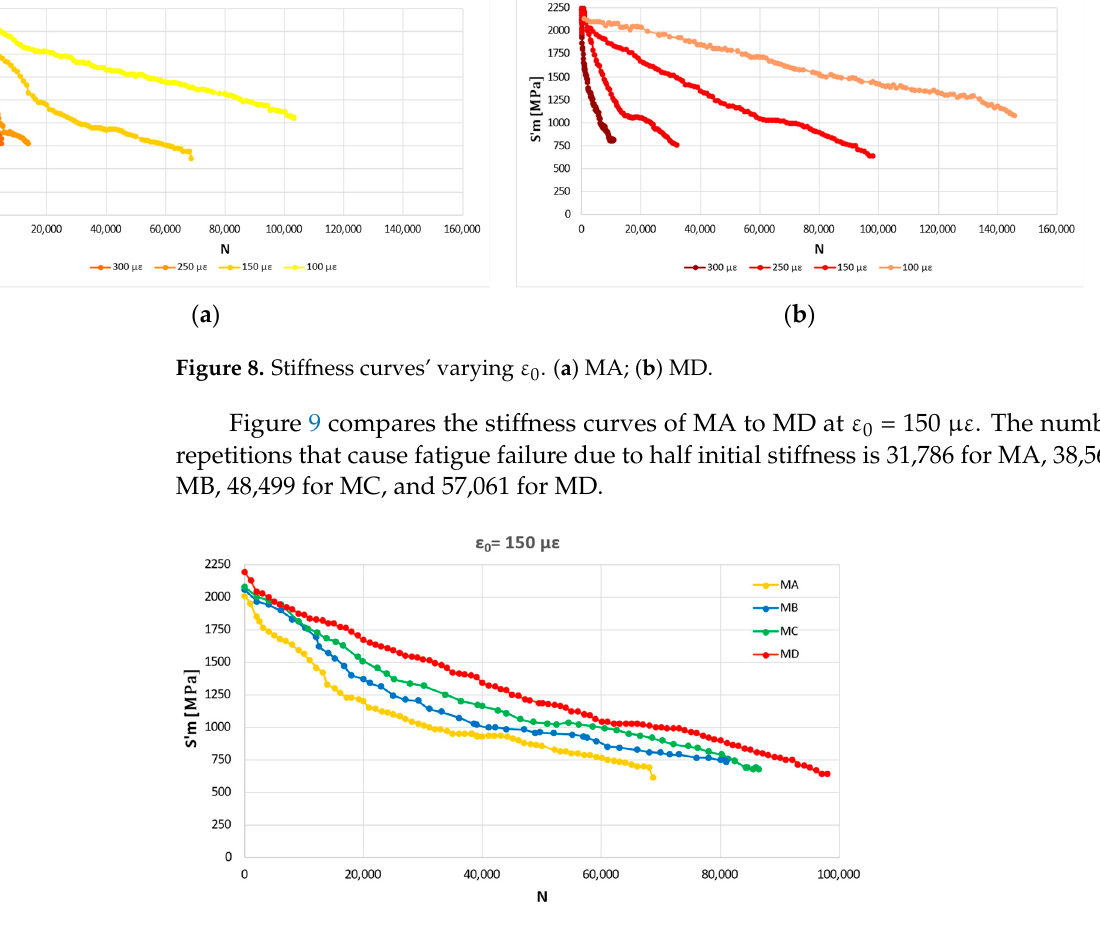
Figure 9. Mi stiffness curves at ε 0 = 150 µε .